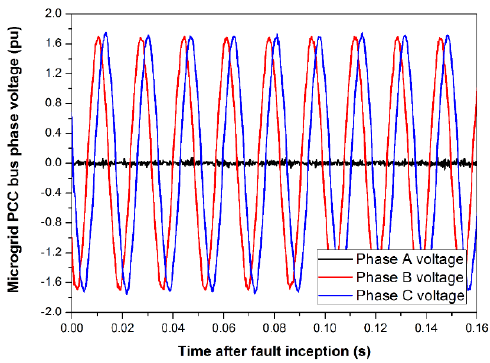
Figure 20. The point of common coupling (PCC) bus voltage during a microgrid fault in autonomous mode.